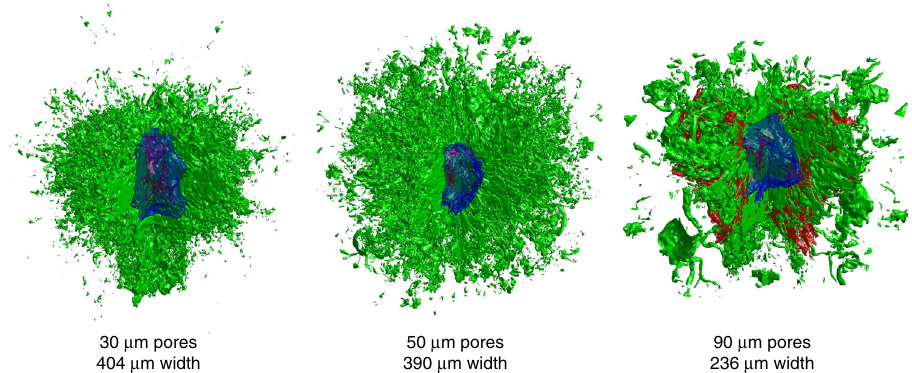
Fig. 5 Simulation visualizations. Visualizations of the shock (red), pore interfaces (green), and hot spot boundary (blue) at bang time for the three different initial pore sizes. A quadrant has been cut out of the shock and pore data in order to aid in the observation of internal